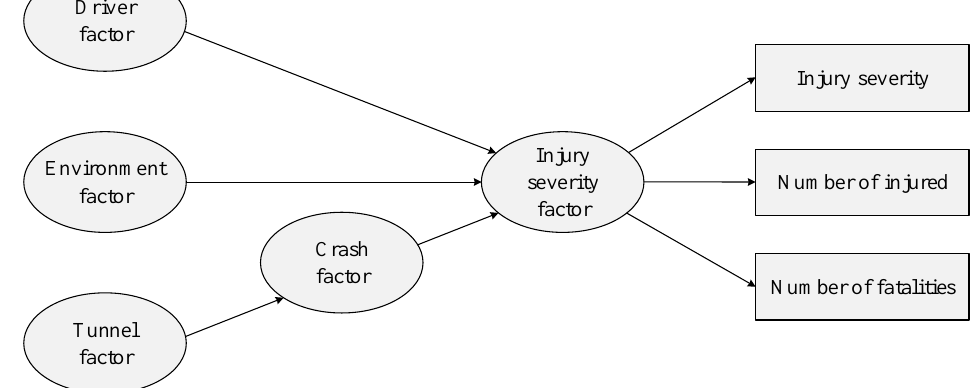
Figure 4. The conceptual model of injury severity in tunnel crashes. H1: Driver characteristics are interconnected with injury severity. H2: Environmental characteristics are interconnected with injury